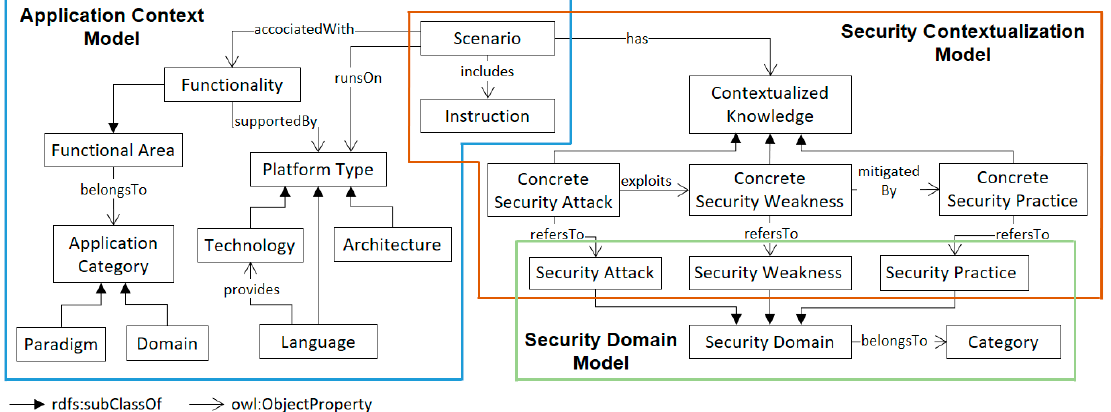
Figure 5. The ontology-based security knowledge model.